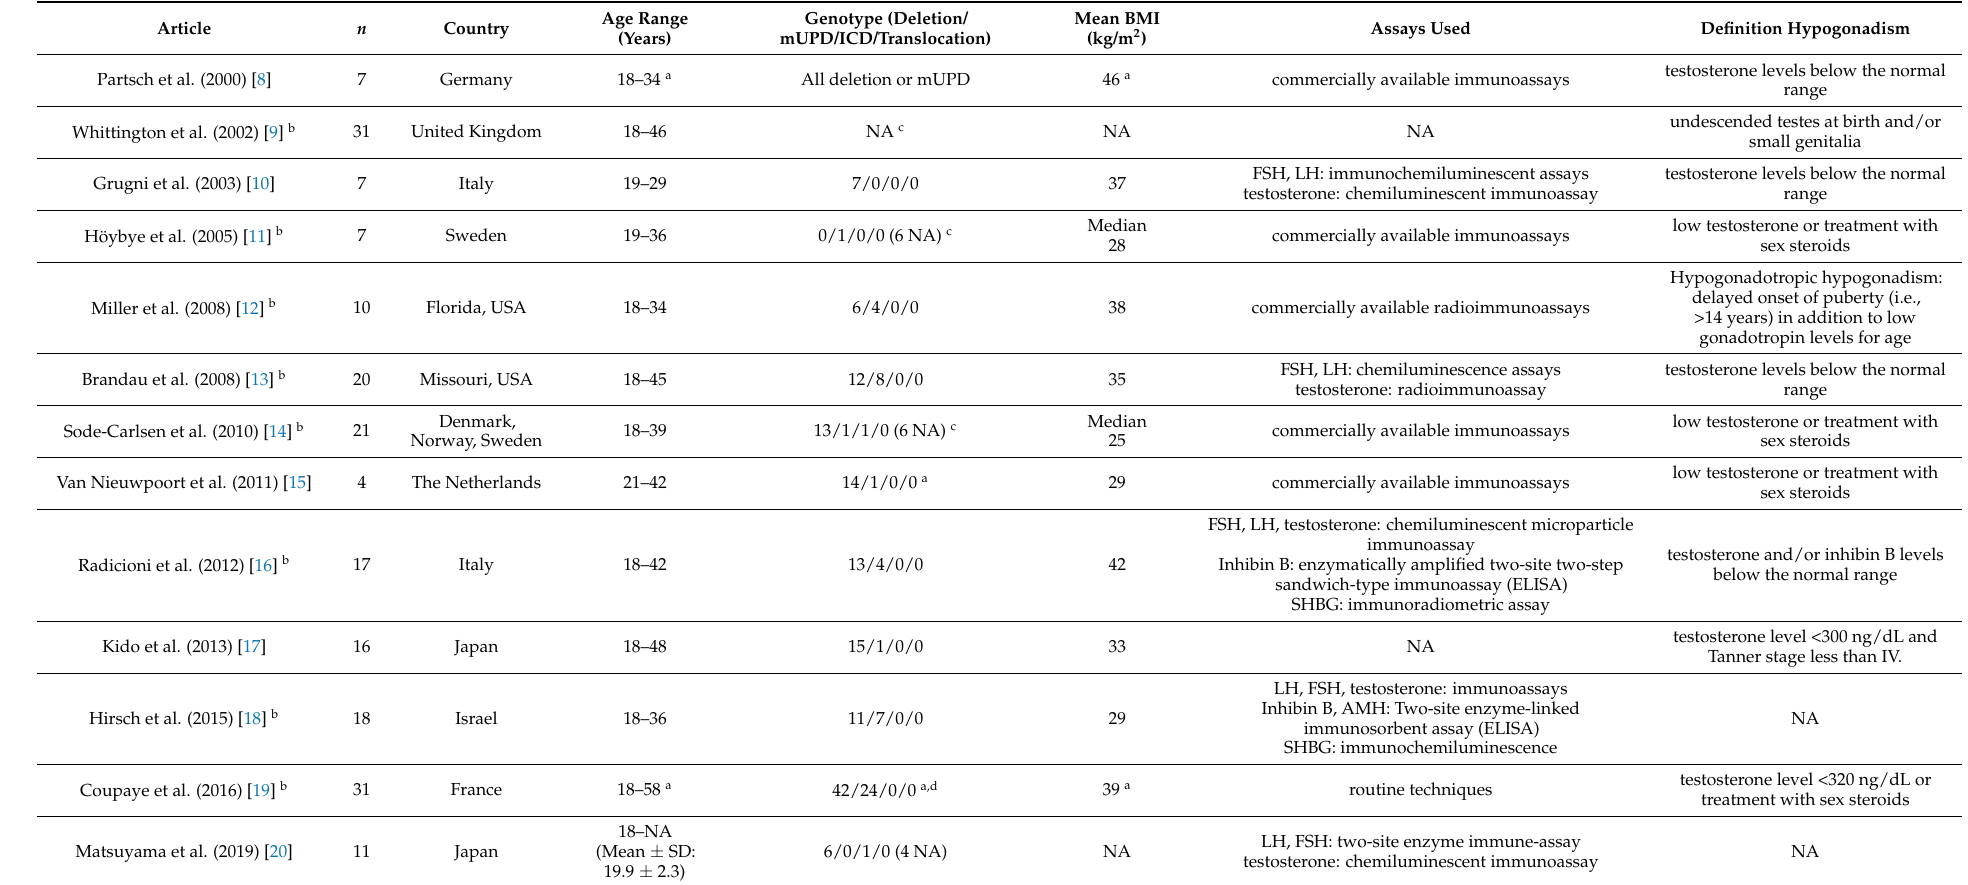
Table 5. Literature review hypogonadism in male adults with PWS (Part